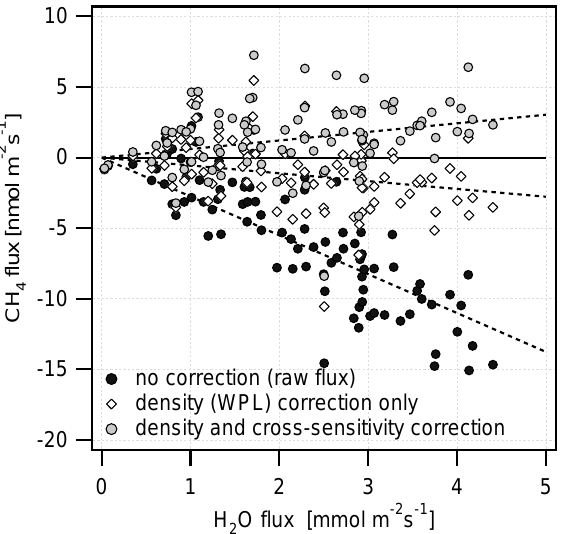
Fig. 4. Scatter plot of the evaluated CH 4 fluxes at different stages of corrections. These data were recorded with the QCLAS at the same site during August 2008 when water vapour fluxes were high and no significant methane fluxes were expected. The dashed lines show linear regression curves (forced through zero) for the three data-sets. The regression line slope for the data with “no correction” is − 2 . 7nmol CH 4 (mmolH 2 O) − 1